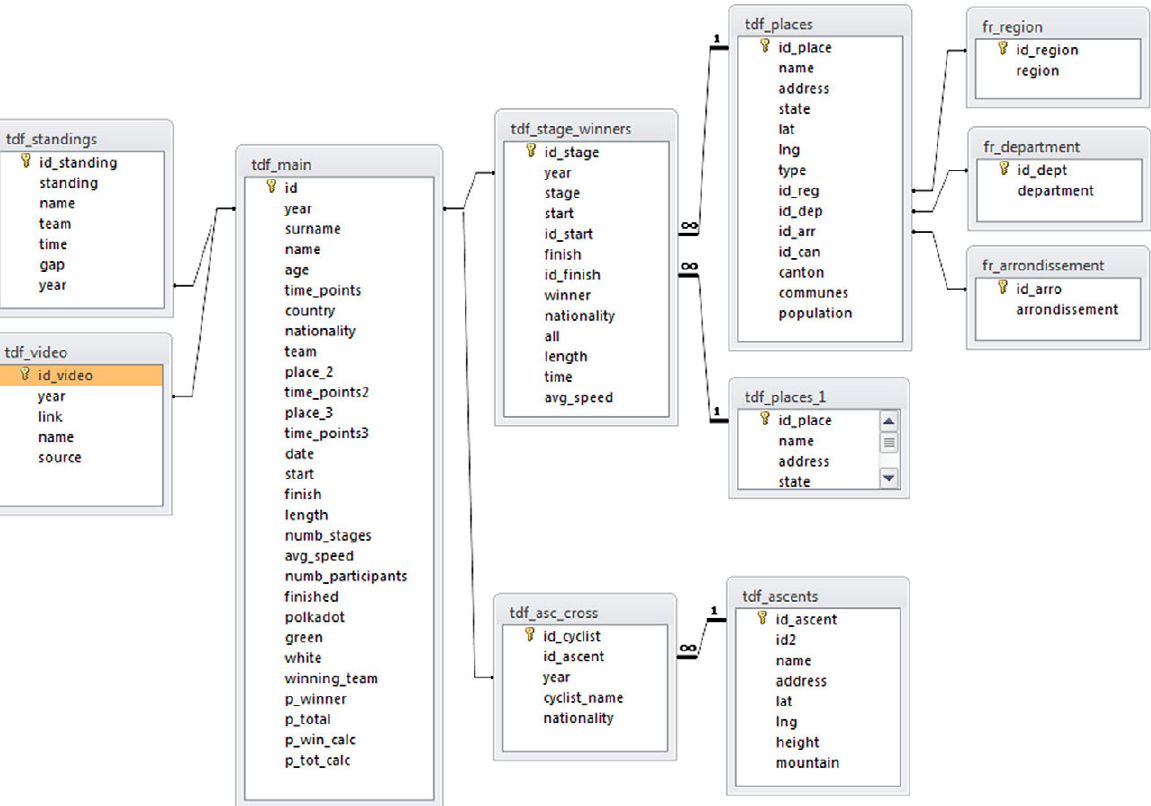
Fig. 1. A scheme of final database tables (the MS Access